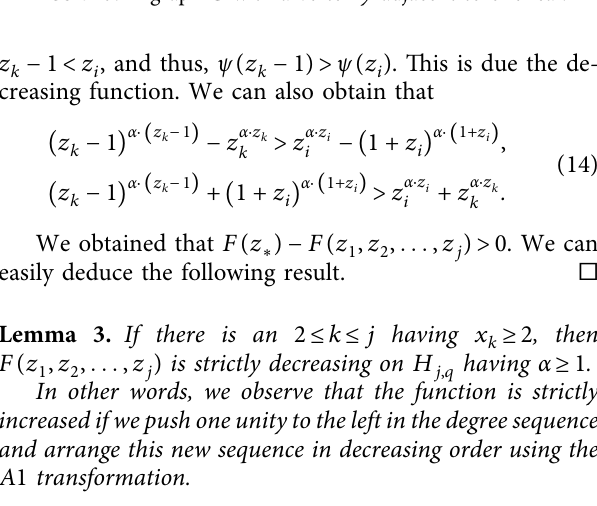
Figure 5: A graph G with a vertex y adjacent to one leaf.